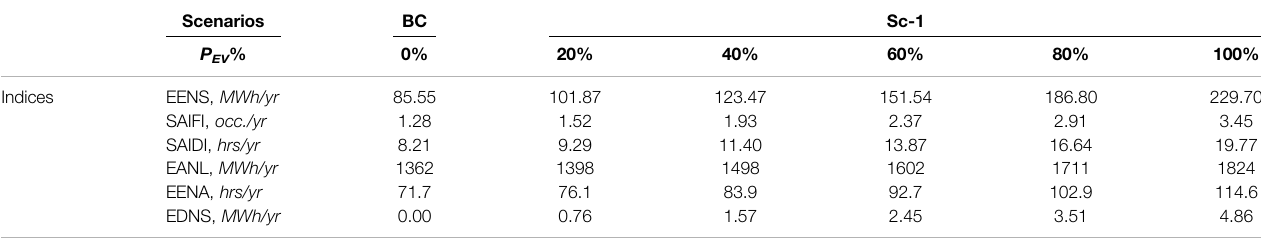
TABLE 6 | Network performance indices of the base case and Sc-1